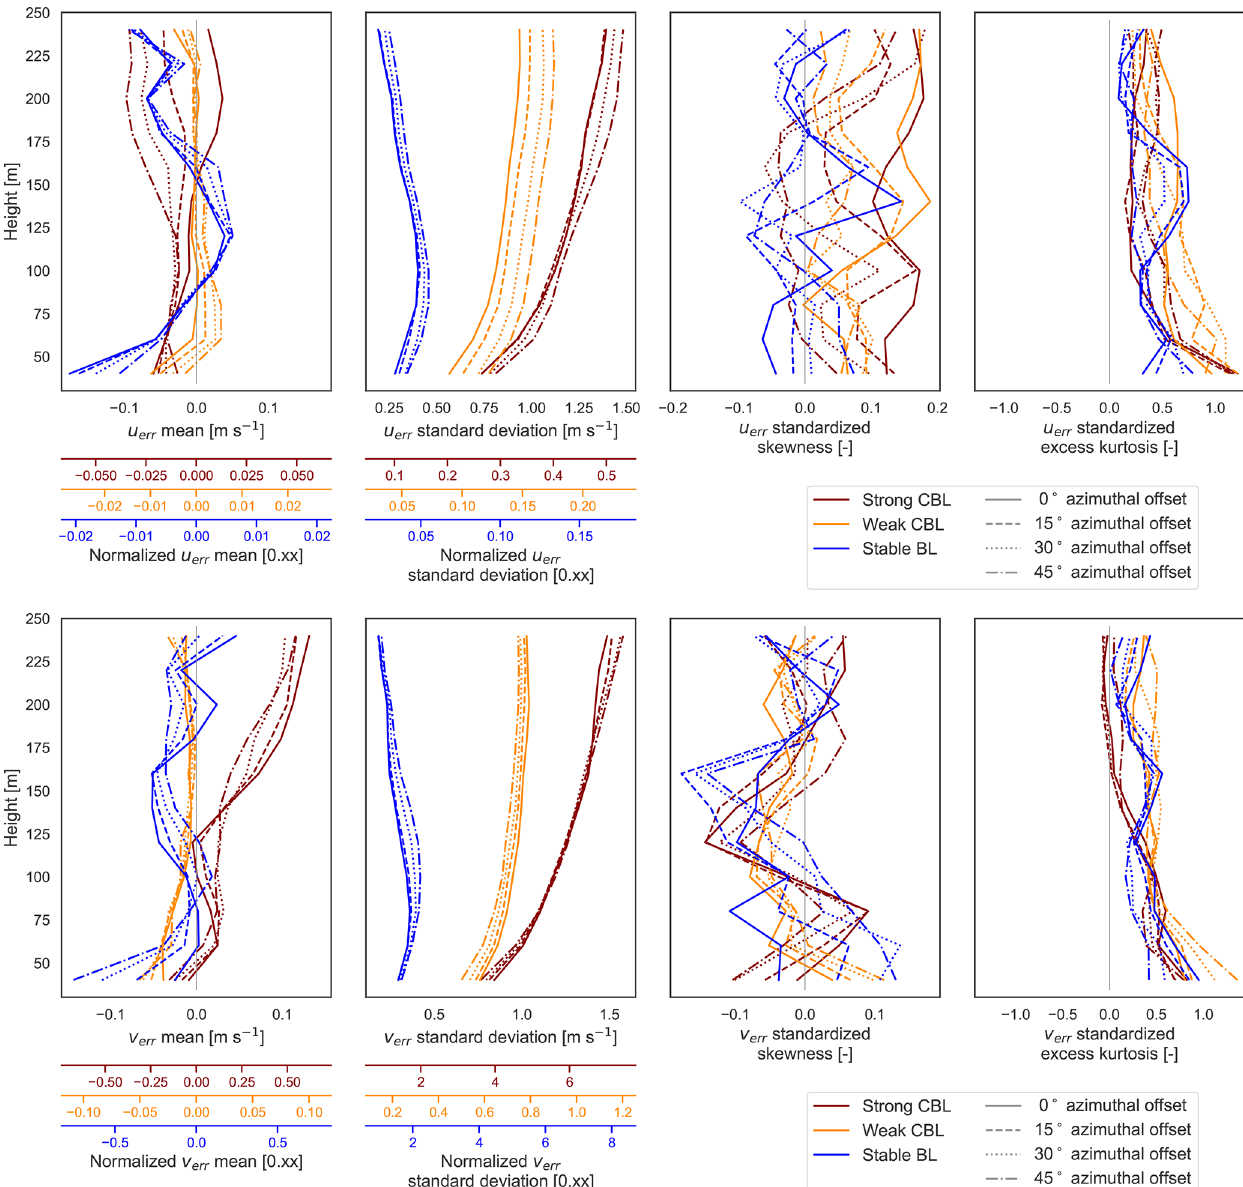
Figure A1. Comparison of u and v error distribution moments over disaggregated lidar orientation angles. No offset, same axes as LES domain (solid), rotated 15 ◦ counterclockwise from LES domain axes (dashed), rotated 30 ◦ counterclockwise (dotted), and rotated 45 ◦ counterclockwise